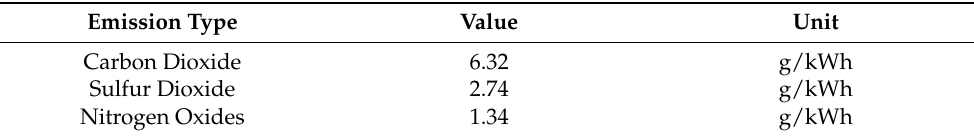
Table 1. Grid greenhouse gases based on Iran’s national grid factors [74].